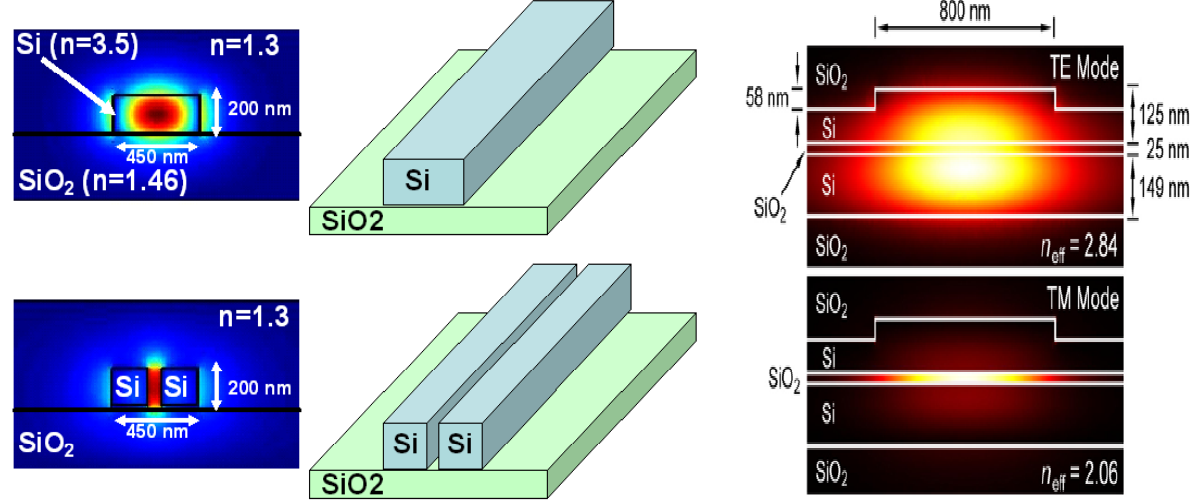
Figure 8. Nanoscopic silicon photonic waveguides including vertical and horizontal slot waveguides, together with computed mode profiles, are